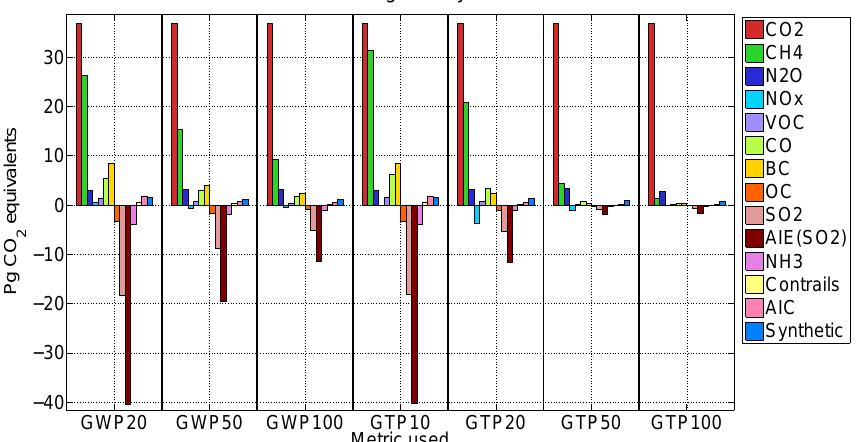
Fig. 9. The weighting of the different emissions from 2008, with BC and OC data from 2005, using various emission metrics.